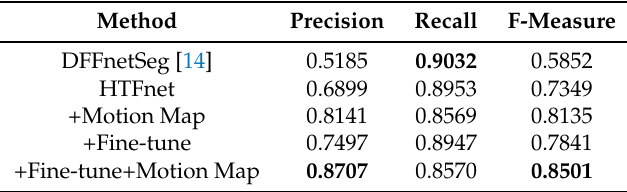
Table 7. Evaluation values of the model if the different components are added. The best results are shown in bold